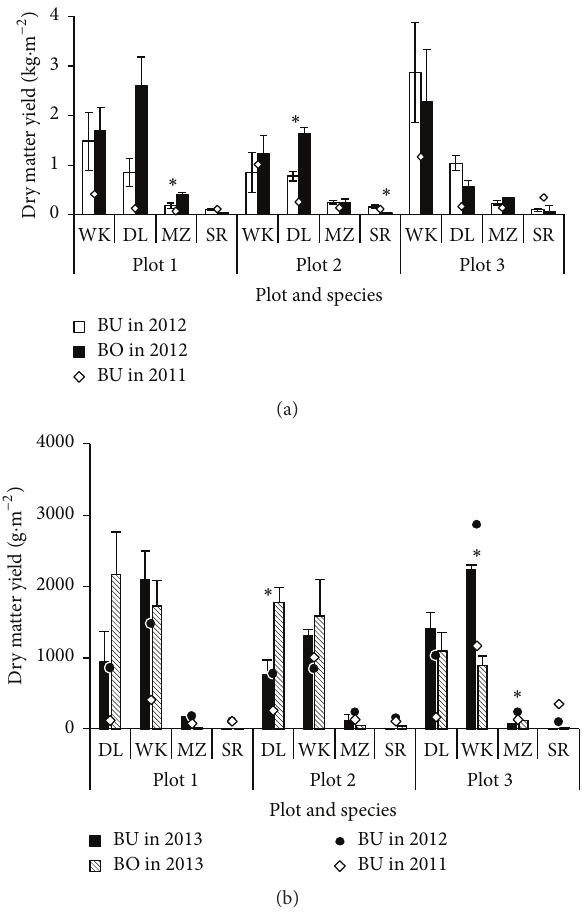
Figure 4: Dry matter yield at the harvest in late autumn in BU area on December 20, 2011, and in both BU and BO areas on November 3, 2012 (a), and in both BU and BO areas on November 15, 2013 (b) (mean ± standard deviation). ∗ shows the difference between BU and BO areas at 5% level. For both plots and species, refer to Figure